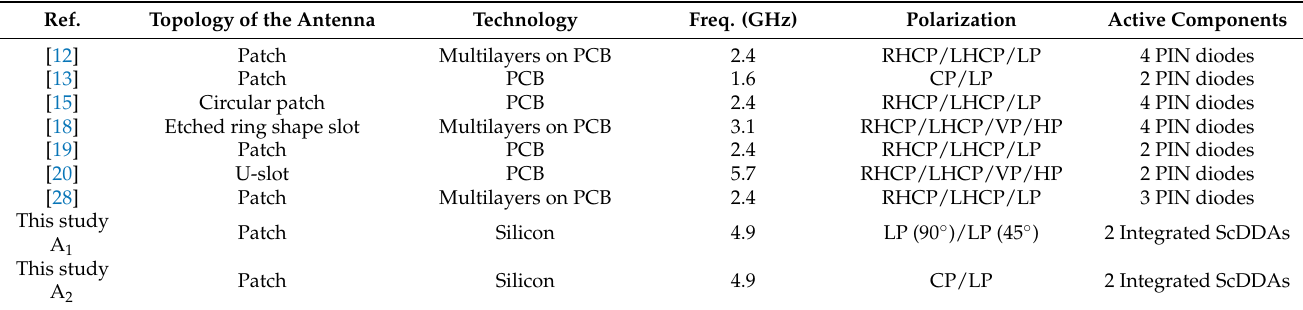
Table 3. A comparison between previous polarization reconfigurable antennae and this